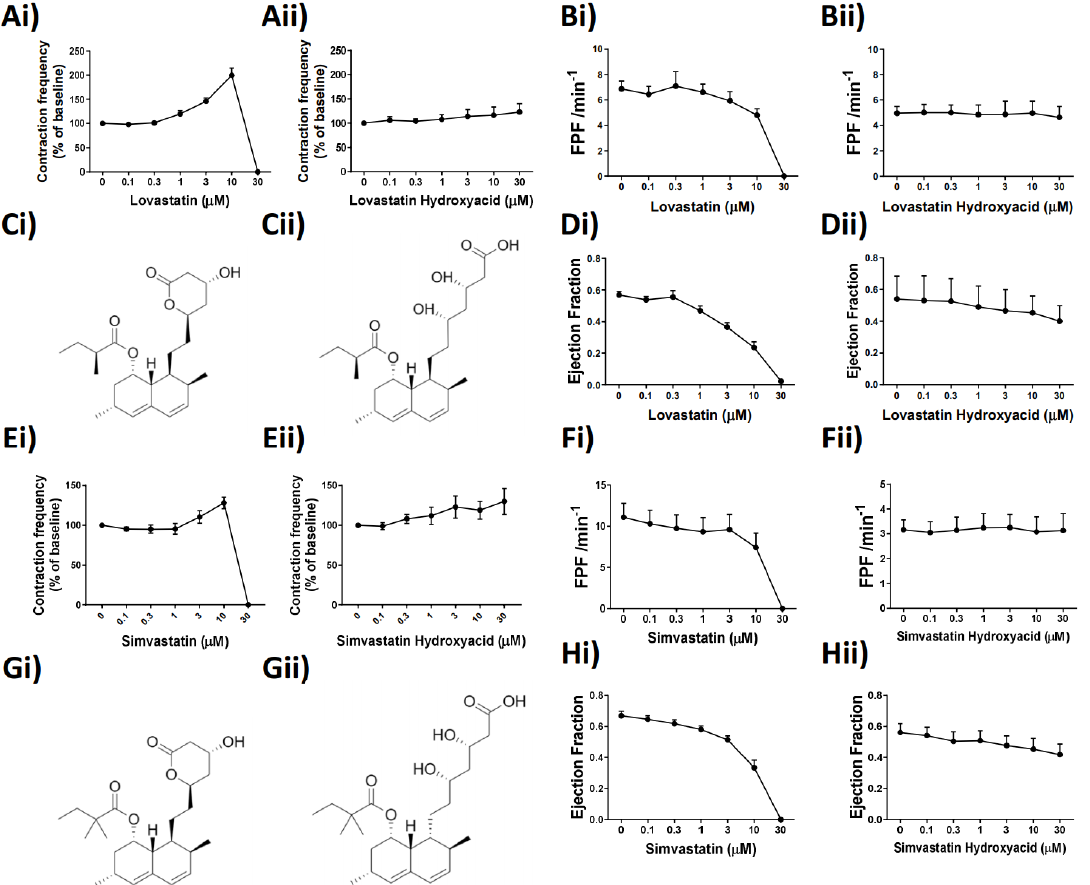
Figure 2. The lactone ring structures of Lovastatin and Simvastatin are intrinsic to the statin-induced alteration of mesenteric lymphatic vessel contraction frequency, ejection fraction, and fractional pump flow. ( Ai ) Lovastatin vs. ( Aii ) Lovastatin-hydroxyacid (contraction frequency/baseline (%) concentration–response curve) ( B ) Calculated fractional pump flow (FPF) and ( D ) ejection fraction (EF) of vessels in response to concentration-dependent stimulation of statin used in A and E, respectively. ( Ei ) Simvastatin vs. ( Eii ) Simvastatin-hydroxyacid (contraction frequency/baseline (%) concentration–response curve). ( Fi , Fii ) Calculated Fractional pump flow (FPF) and ( Hi , Hii ) ejection fraction (EF) of vessels in response to a concentration-dependent increase in Simvastatin or Simvastatin Hydroxyacid. ( C , G ) Skeletal chemical structures of drugs used in panels i and ii. n = 4–12 lymphatic vessels from 4–12 different rats. Chemical structures drawn using ChemDraw.